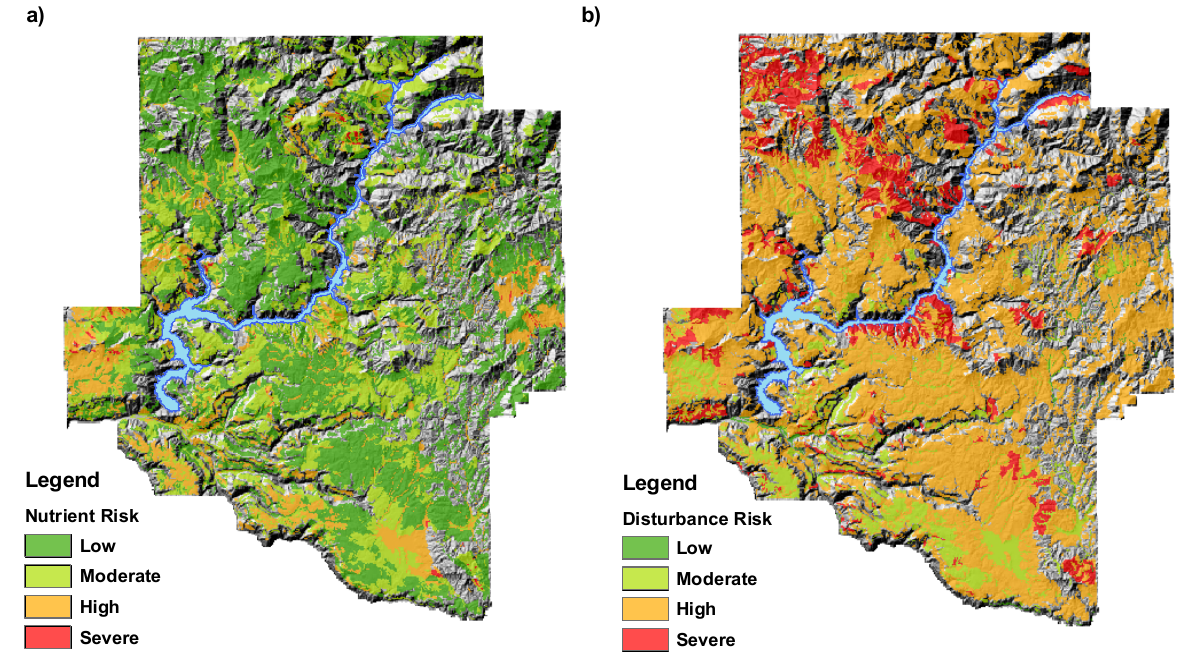
ecoregion, USA; ( b ) Soil disturbance risk assessment to long-term soil productivity following ground-based harvest activities in the ID612 survey area. Gray scale areas represent excluded landforms with >45 percent slope